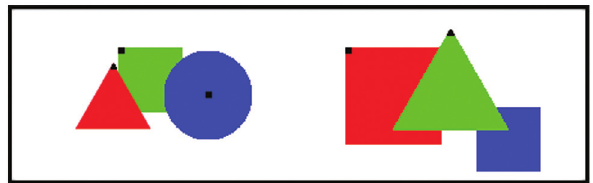
Figure 8. Sample with Green